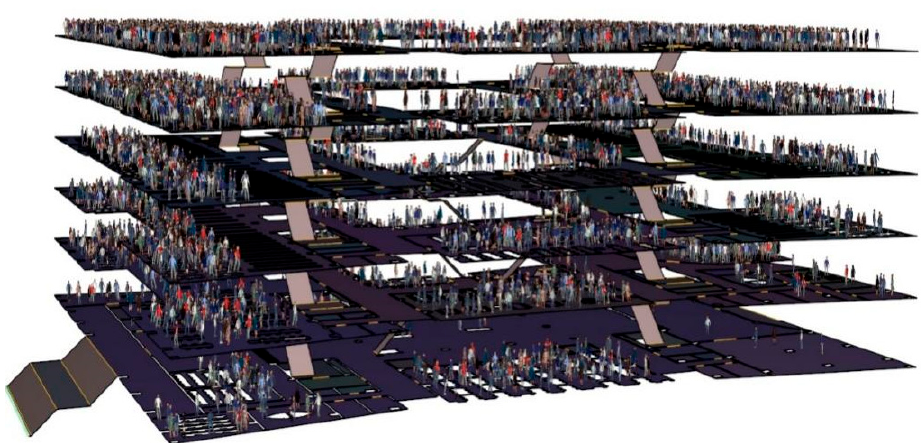
Figure 2. Building library internal model based on Revit.